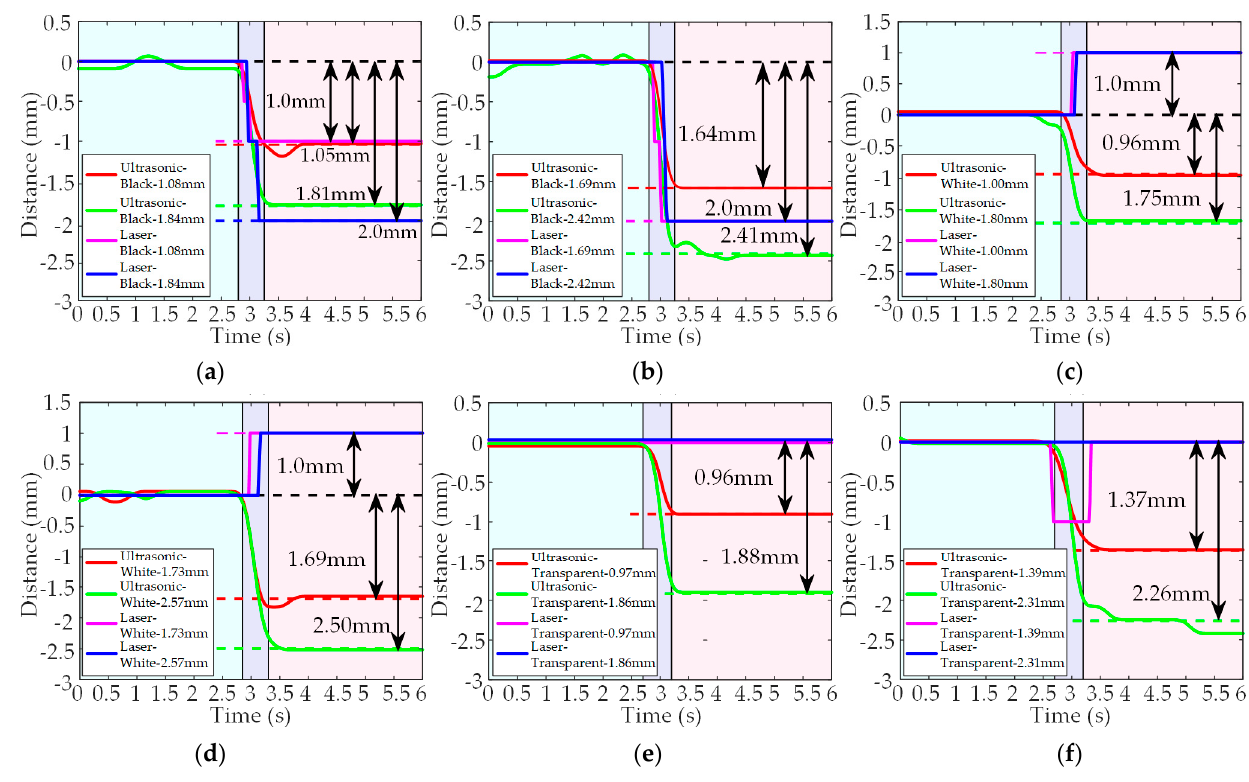
Figure 10. Detection results of the PMUTs-based ultrasonic sensor and the laser sensor when using black acrylic plates with thicknesses of 1 mm and 2 mm ( a ), 1.5 mm and 2.5 mm ( b ), white acrylic plates with thicknesses of 1 mm and 2 mm ( c ), 1.5 mm and 2.5 mm ( d ), transparent acrylic plates with thicknesses of 1 mm and 2 mm ( e ), 1.5 mm and 2.5 mm ( f ) in the dynamic experiments.